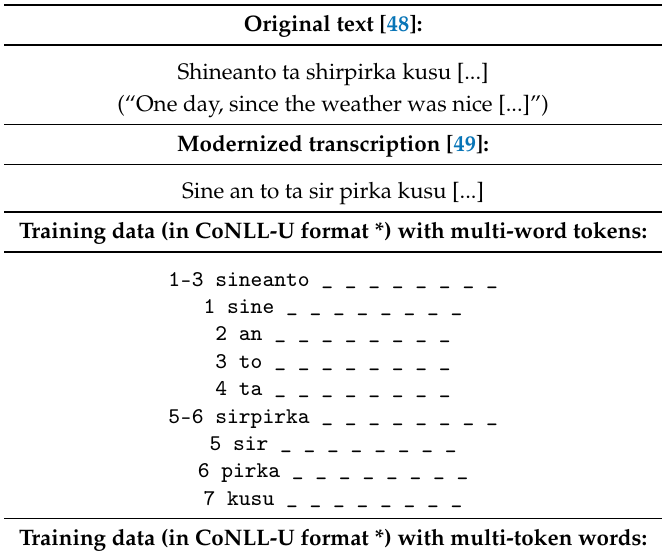
Table 4. Operations on training data for the Universal